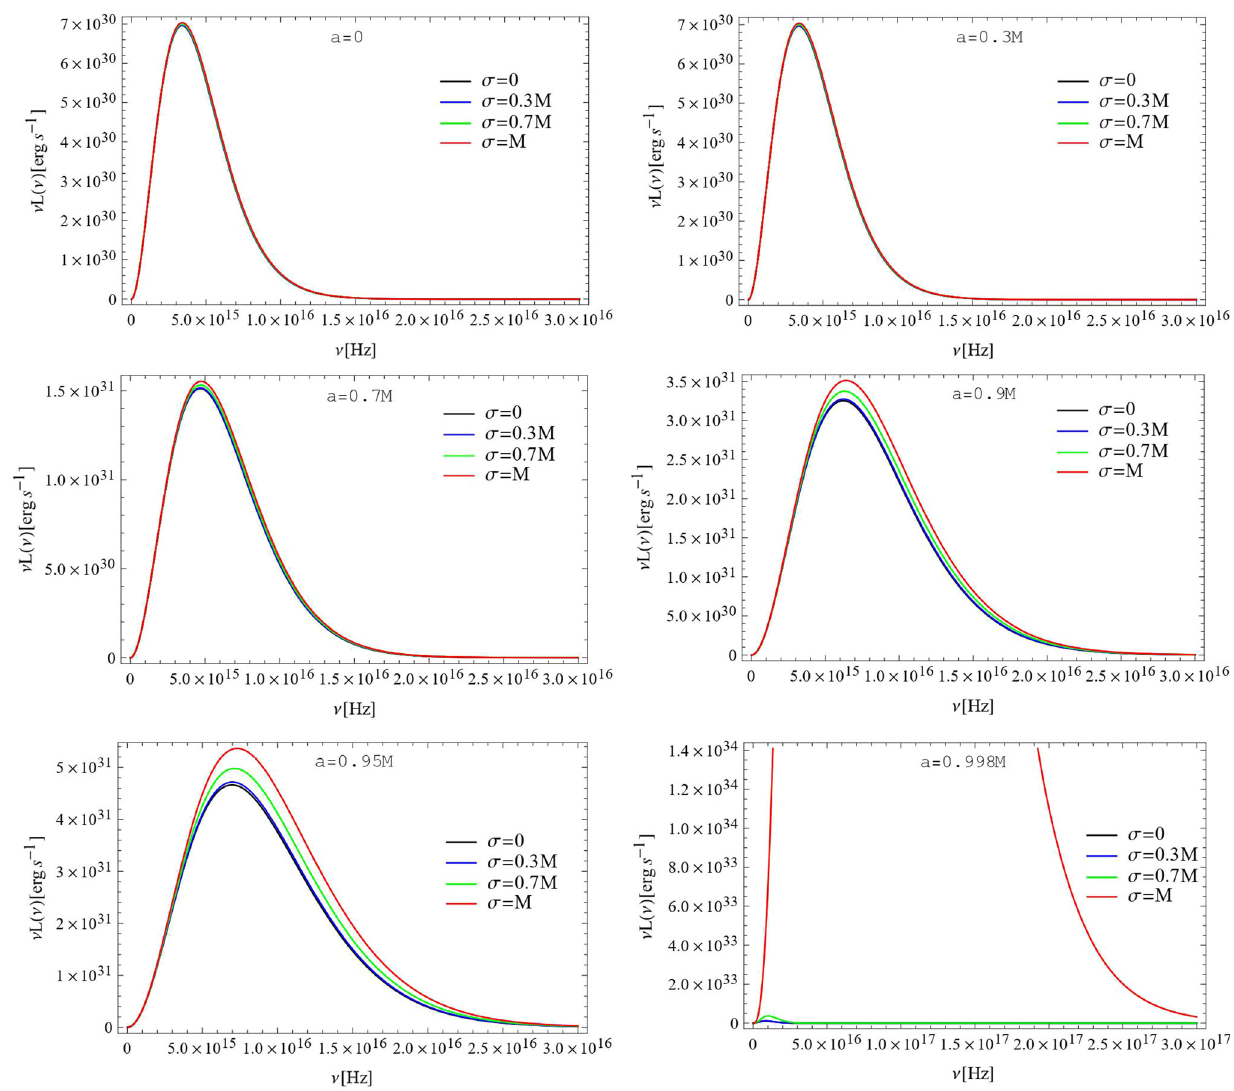
Fig. 3 Variation of luminosity ν L (ν) in [erg.s − 1 ] with frequency in ν [Hz]